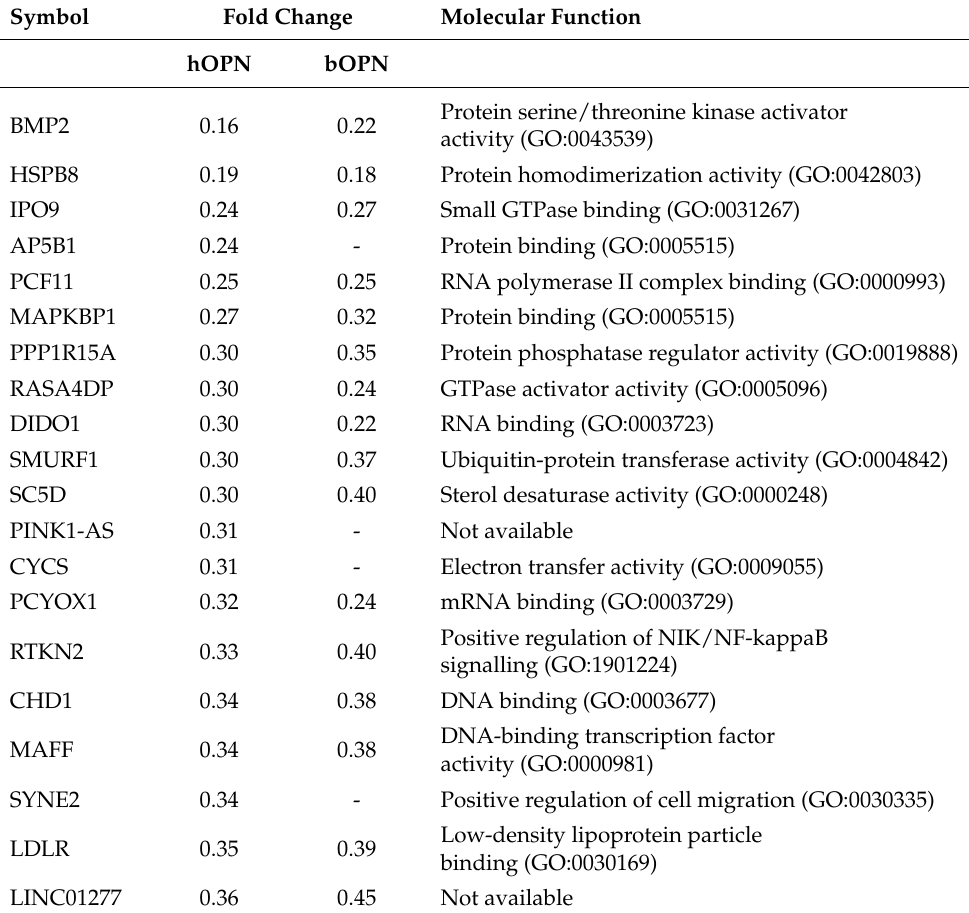
Table 3. Twenty most downregulated differentially expressed genes (by Fold change)( p -adjust <0.01 LCF > |1|). Human milk OPN (hOPN) and bovine milk OPN